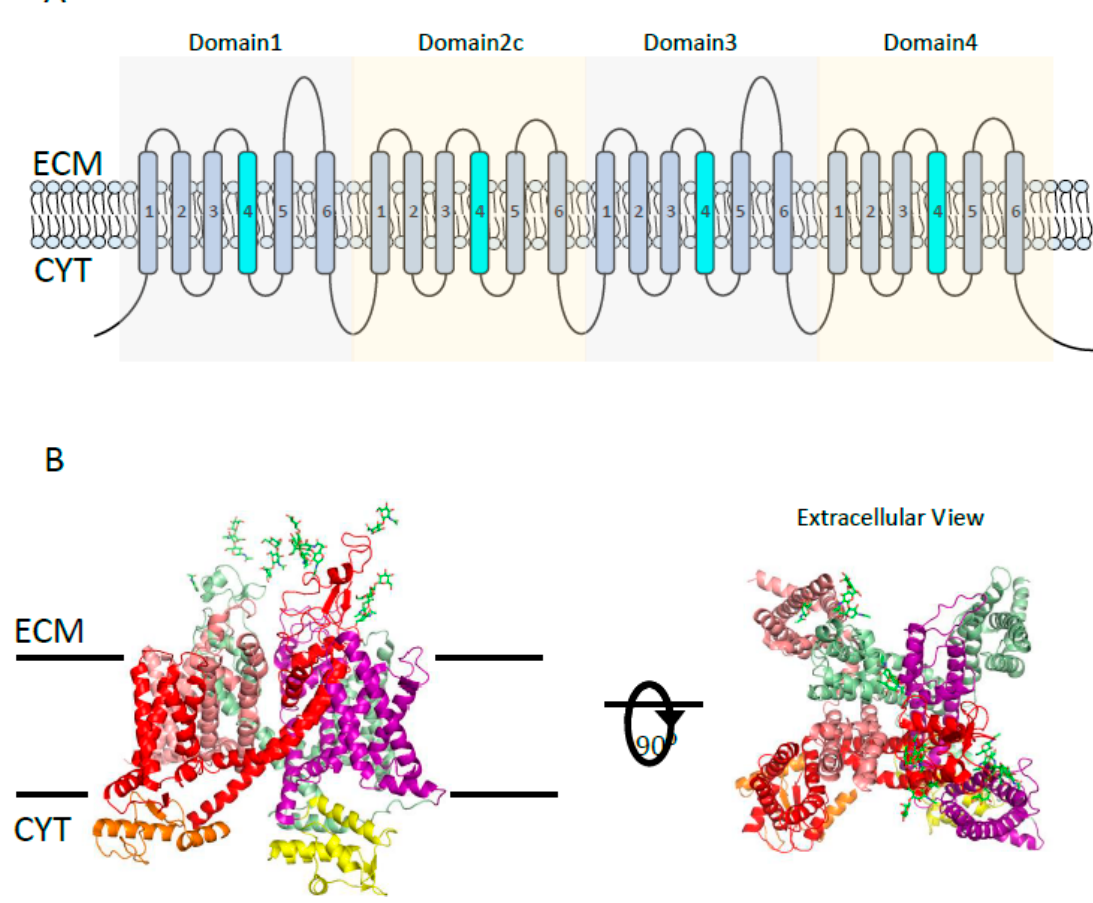
Figure 7. NaV channel structure. ( A ) The topology of the α subunit of NaV channel, showing 24 transmembrane segments (TMS) and four domains (D1–4). Each domain consists of 6 TMS, a pore between the 5/6 TMS, and TMS4 as a voltage sensor (shown in cyan). ( B ) Overall 3D-architecture of the α -subunit of eukaryotic NaV channel (Protein Data Bank [PDB] code 5XOM). Left: the side view of the NaV channel domains D1 (red), D2 (salman), D3 (smudge), and D4 (purple) are shown with N- and C-terminal domains colored in orange and yellow, respectively. Glycosylations located in the extracellular loops of D1 and D3 are represented by green sticks. Right: the extracellular view of the NaV channel showing four domains surrounding the channel pore. ECM = extracellular milieu; CYT = cytoplasm.